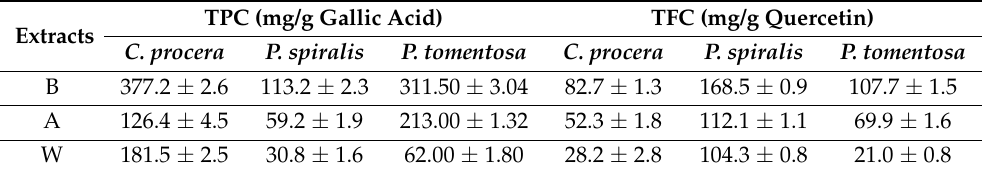
Table 3. TPC and TFC of all extracts of C. procera , P. spiralis and P. tomentosa .